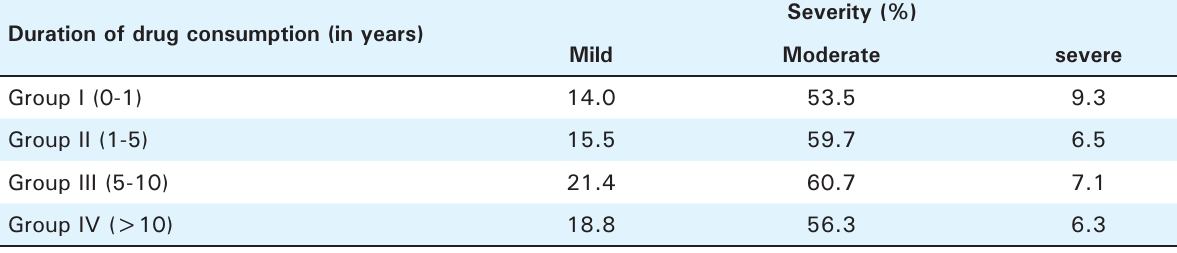
Table 3. Relation between plaque index and severity Plaque index